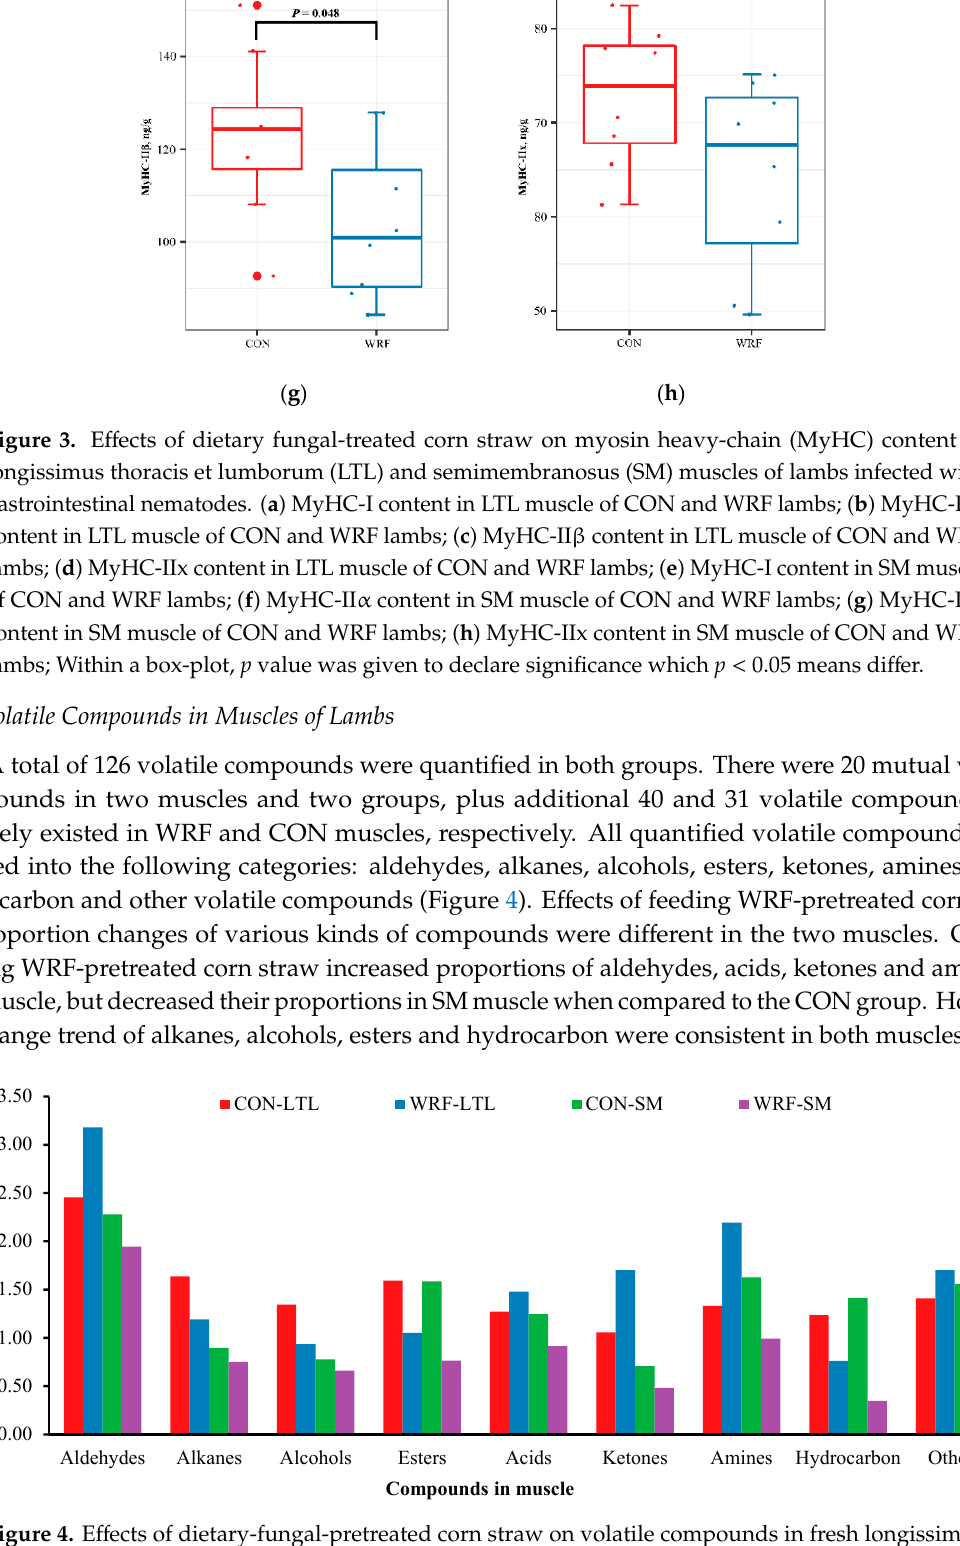
Figure 4. Effects of dietary-fungal-pretreated corn straw on volatile compounds in fresh longissimus thoracis et lumborum (LTL) muscle and semimembranosus (SM) muscle of lambs infected with gastrointestinal nematodes.